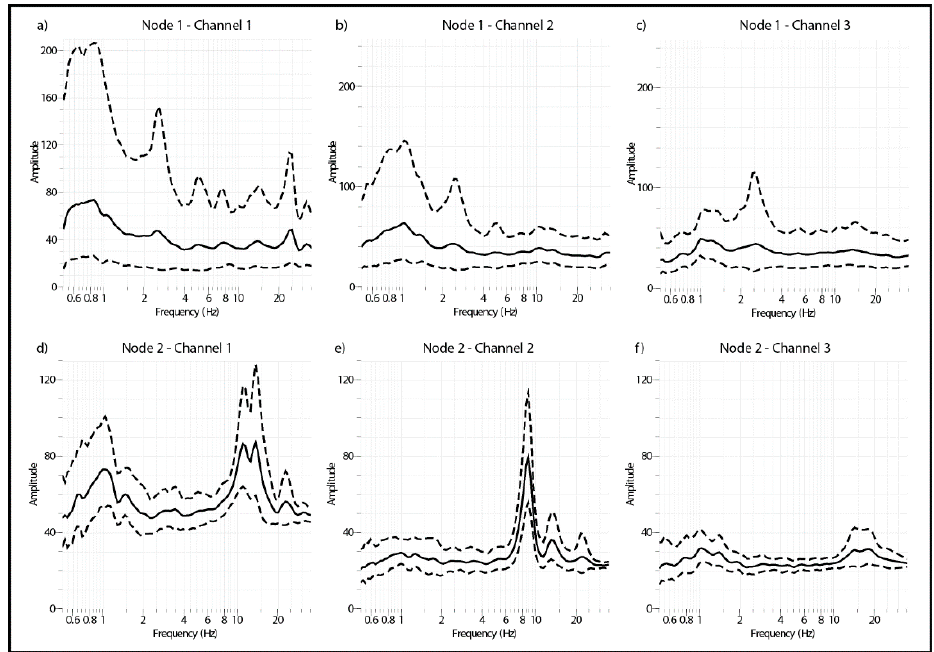
Figure 21. Power spectral density of the recordings shown in Figure 20.